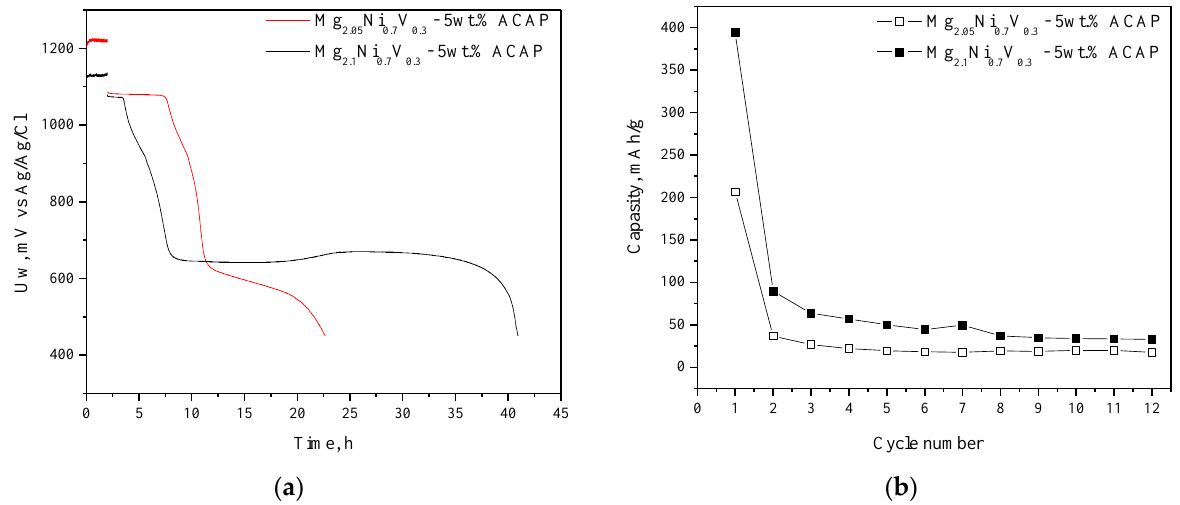
Figure 5. Discharge capacity vs. cycle number ( a ) and first charge and discharge curves ( b ).